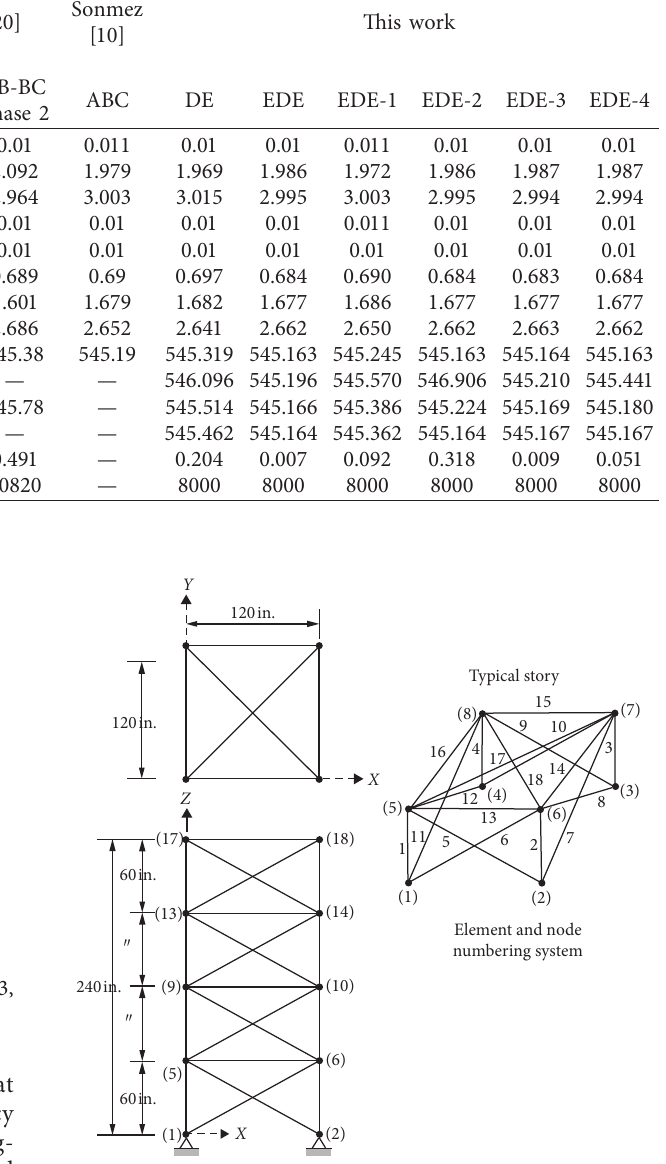
Figure 10: Configuration of the 72-bar truss (reproduced from